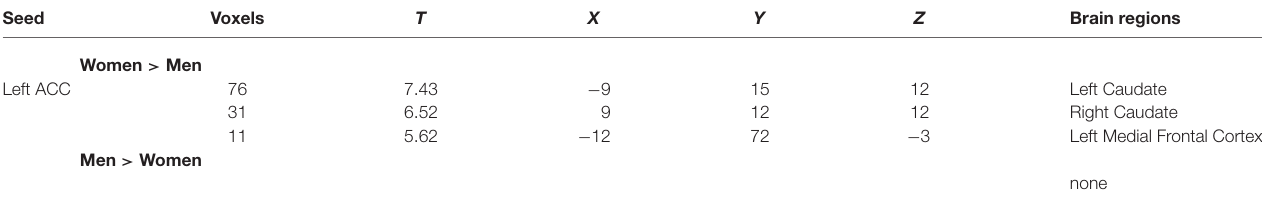
TABLE 3 | Sex differences on seeds to whole brain voxel-wise resting-state functional connectivity (RsFC) analyses. Seed Voxels T X Y Z Brain regions Women > Men Left ACC 76 7.43 − 9